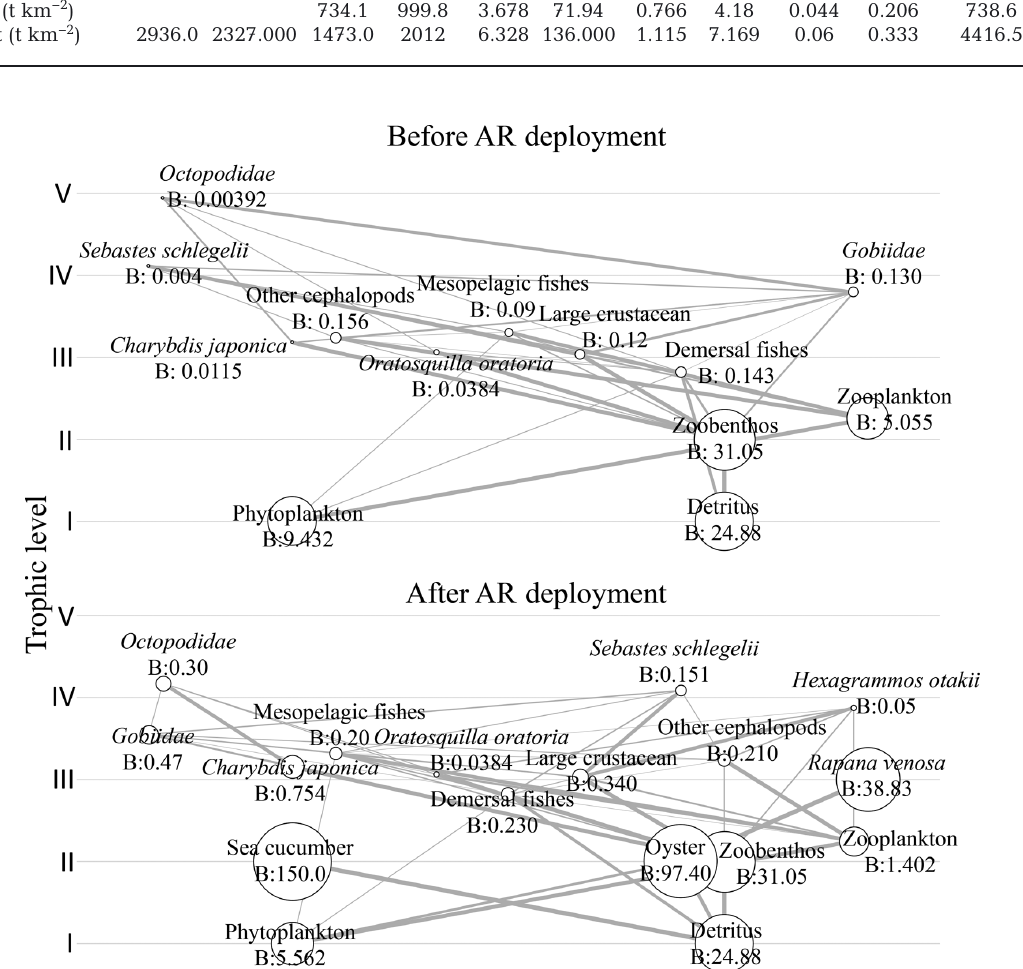
Fig. 2. Flow diagrams representing food web structure (Ecopath with Ecosim modeling) in terms of functional groups and frac- tional trophic levels before and after artificial reef (AR) deployment. Circles are distributed on the y -axis according to trophic level (I−V); circle size is proportional to each group’s biomass. Biomass (B) is reported in t km − 2 . Line thickness illustrates